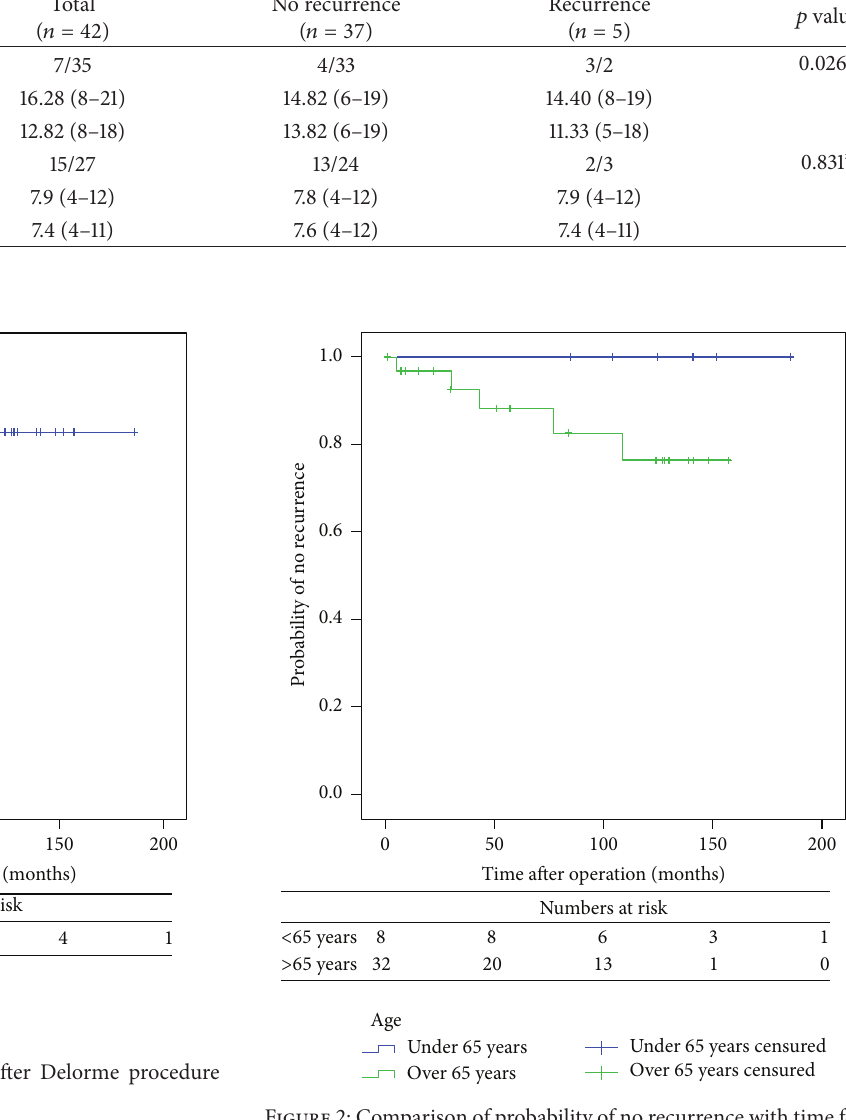
Figure 2: Comparison of probability of no recurrence with time for patients according to age (Kaplan-Meier